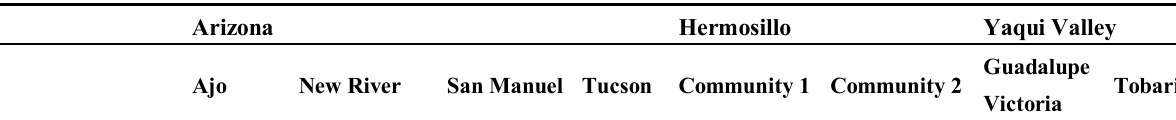
Table 4. Arsenic Levels in Water and Estimated Total Arsenic Intake from Drinking Water and Other Beverages during 24 h by Recruitment